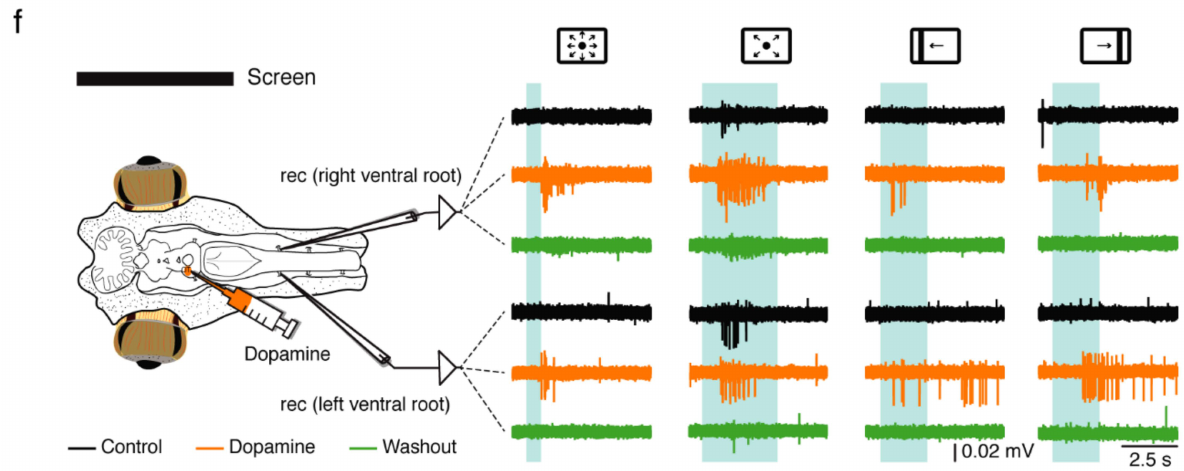
Figure 3. Two-component response of dopaminergic neurons. ( a ) Dopaminergic SN/VTA neurons show a two-component phasic response. The first component depends only on the salience (physical intensity) of the stimulus. The second component depends on the inferred value of the stimulus. The process of moving from salience/detection to object valuation has been proposed to take place via intermediate steps mediated by different brain areas. For visual stimuli, the SC/tectum has been proposed to provide the salience/detection information, whereas additional areas, including the cortex, are involved in the identification and evaluation of the stimulus. However, it is not yet fully understood where and how this processing takes place (modified from [59]). ( b ) Retrogradely labeled neurons in the tectum after a neurobiotin injection in the SNc/VTA indicate that the same pathway thought to convey salience information to the SNc/VTA in mammals is also present in lampreys. Scale bar: 100 µ m. ( c ) The SNc/VTA in the lamprey signals visually salient responses. When looming stimuli (a dot expanding in the screen) are presented to an eye–brain preparation allowing visual stimuli to be presented while recording electrophysiological activity, the responses in the SNc/VTA increase in parallel to the speed of the stimulus. Representative traces at two different speeds are shown in ( d ). The shadowed area indicates the duration of the visual stimulation and its level of salience. ( e ) Graph showing the increase in SNc/VTA activity parallel to the increase in looming speeds. ( f ) The net effect of the dopaminergic innervation from the SNc/VTA to the tectum is an increase in the responsiveness to sensory stimuli. When visual stimuli (looming dots and moving bars) are presented to the eye–brain preparation described above, larger motor responses are evoked after dopamine is injected in the tectum. The traces show the activity in a rostral pair of ventral roots before (black) and after injecting dopamine in the tectum (orange). The effects are reversed after several minutes (green). Modified from